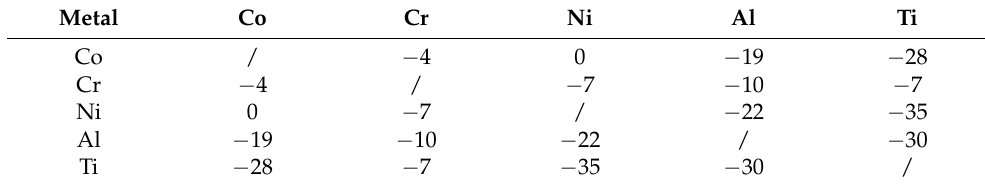
Table 3. Mixed enthalpies among the principal elements of Co 32 Cr 28 Ni 32 . 94 Al 4 . 06 Ti 3 (kJ/mol).